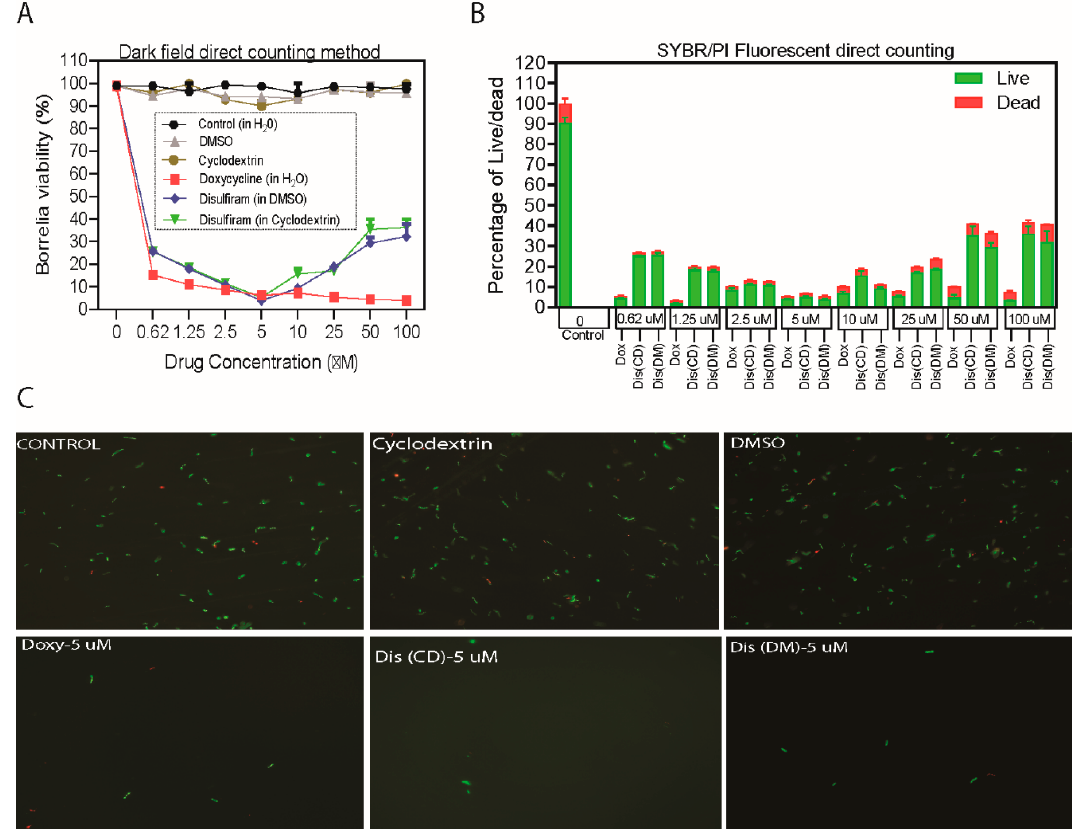
Figure 1. Evaluation of the borreliacidal activity of disulfiram (in DMSO and cyclodextrin) with doxycycline as control. A 4-day-old, B. burgdorferi log phase culture of B. burgdorferi was incubated for four days with disulfiram (Dis-DM), disulfiram (Dis-CD) and doxycycline (Doxy) at the same drug concentrations of 100 µM to 0.625 µM respectively. After a five-day incubation, bacteria cell viability was assessed by ( A ), by direct counting using dark field microscopy and ( B ), by SYBR Green-I/PI assay using fluorescent microscopy. ( C ), Representative images were taken using SYBR green-fluorescent stain (live organisms) and propidium iodide red-fluorescent stain (dead organisms) at 200 × magnification. All these experiments were repeated at least three times ( n = 6). Error bars represent standard errors.